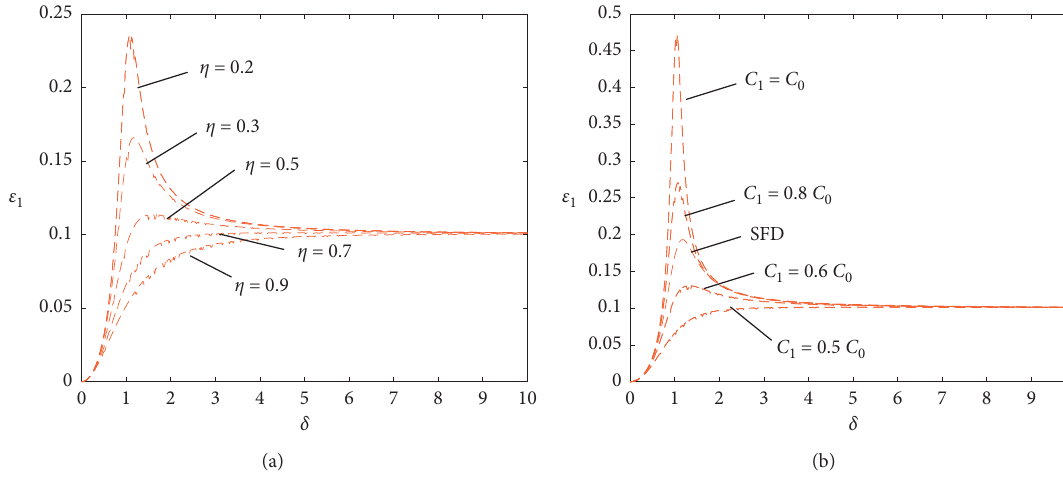
Figure 12: (a) The influence of η and (b) C